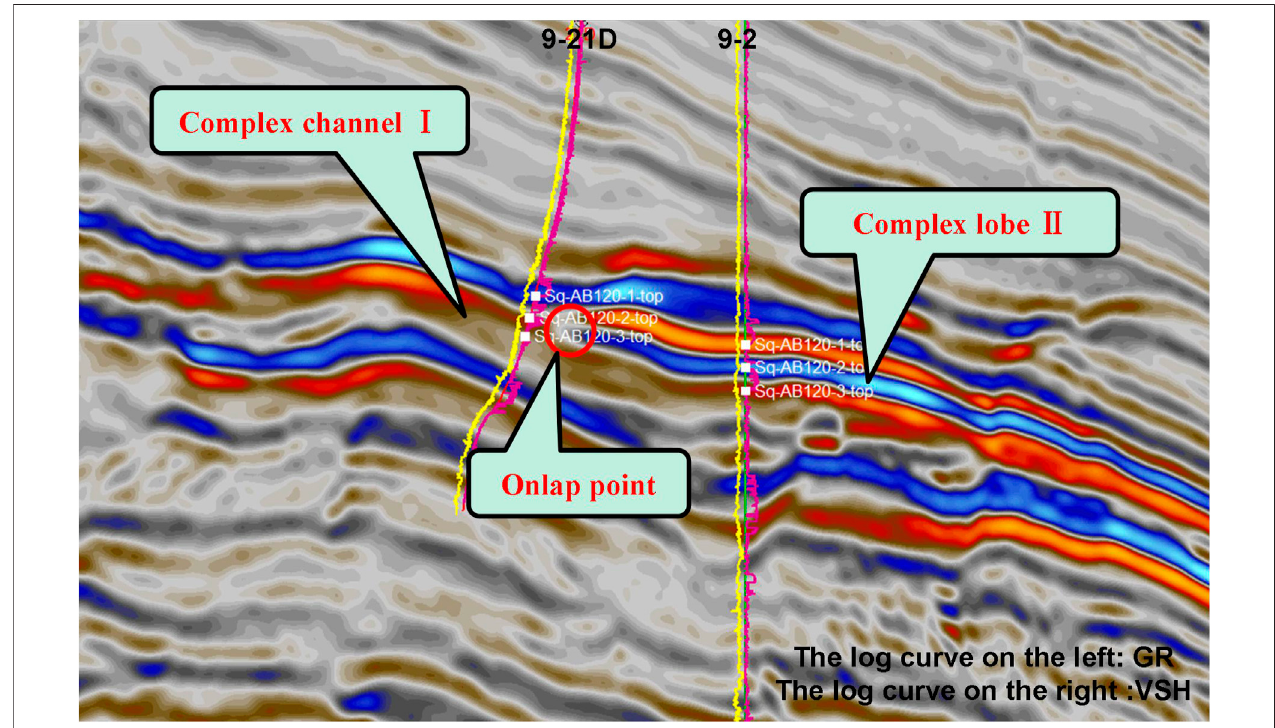
FIGURE 19 | Seismic section of the AB120 reservoir along the source direction and through wells 9 – 21D and 9-2